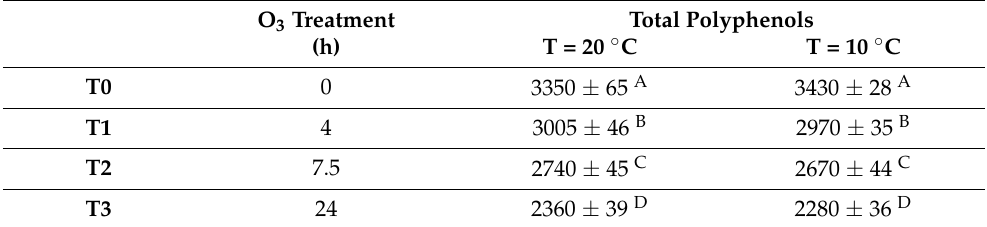
Table 3. Total polyphenols of red mute Lambrusco must treated with O 3 gas (8 µ L/L) for the indicated time of treatment, at 20 and 10 ◦ C. Data are the mean of three glass jars, each temperature ( ± SE) in two replicated experiments. In the column, different capital letters indicate significance at p <